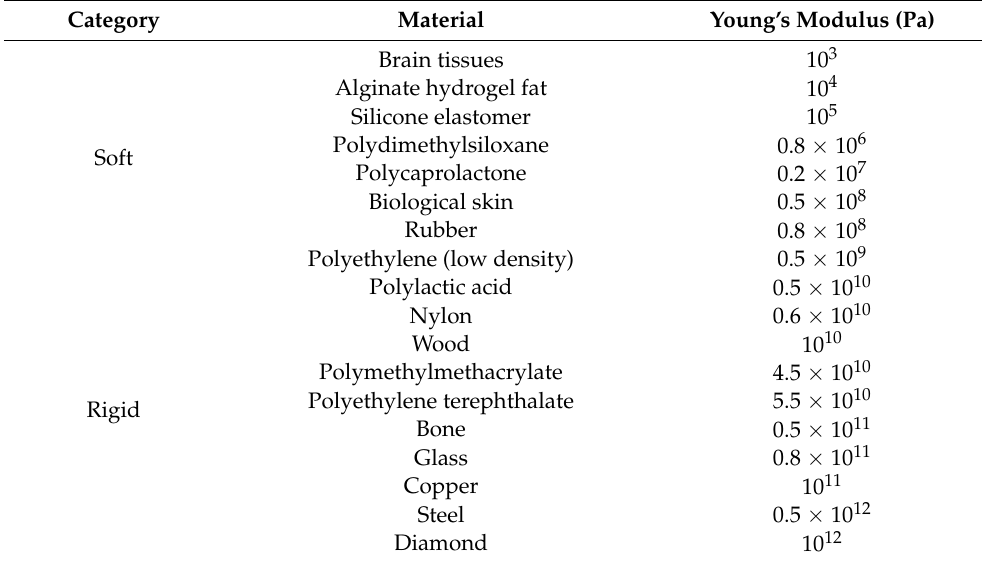
Table 1. Young’s moduli of selected soft and rigid materials [1,14,22].